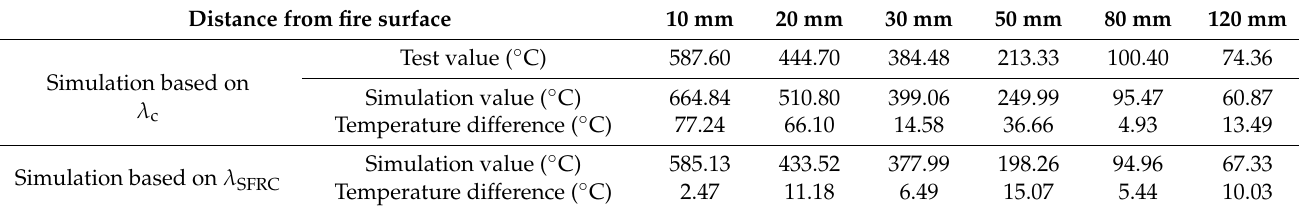
Table 9. Temperature comparison of each section based on different calculation